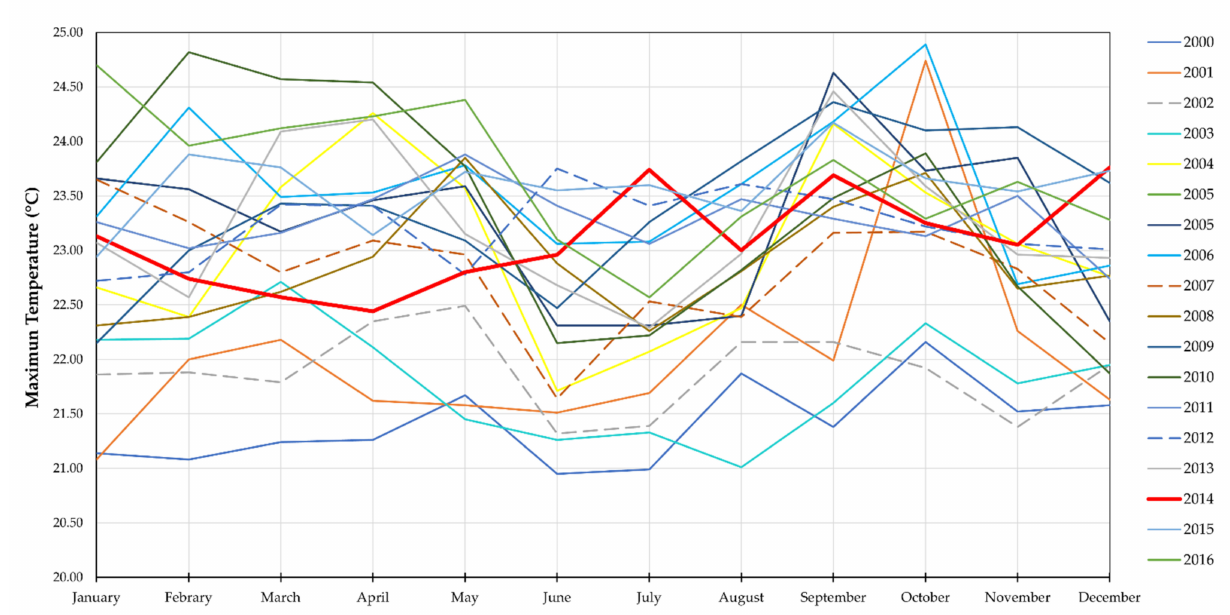
Figure 12. Maximum monthly temperature in the period 2000–2016. Source: adapted from [109,120]. The principal component analysis applied in the Carolina Parish included as variables the precipitations and months. PCA application is fundamental because it describes the local climatological behavior since the area has different microclimates, which is related to forest fire incidence. As a result, the diagram of PCA variables showed a bimodal behavior, which correlated with the region’s two seasonal periods. In other words, the months with the highest precipitation (first quadrant) represent the rainy season and the months with low precipitation (fourth quadrant) represent the dry season (see Figure